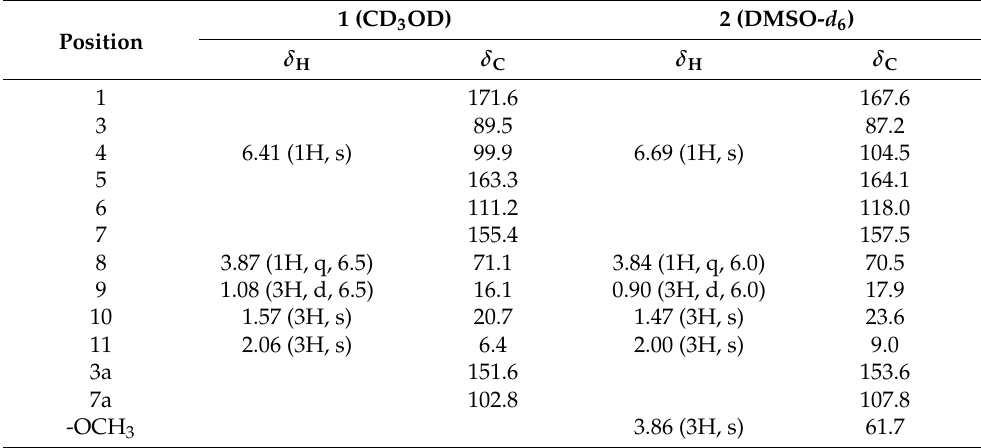
Table 1. 1 H (500 MHz) and 13 C NMR (125 MHz) spectral data of 1 and 2 ( δ in ppm, J in Hz).